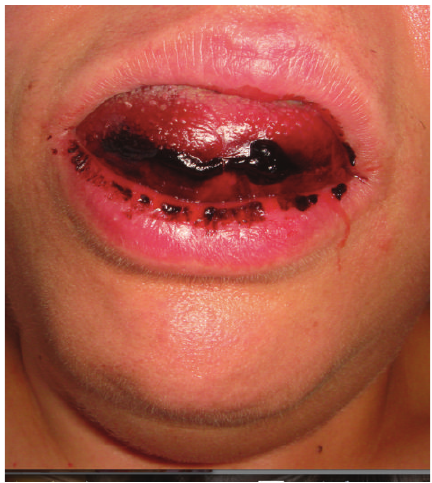
Figure 2: Clinical photograph of the extensive sublingual haematoma two hours after implant placement with the enlarged tongue (triple normal volume), displaced superiorly, pressed firmly against the palate, and protruding extraorally for 3